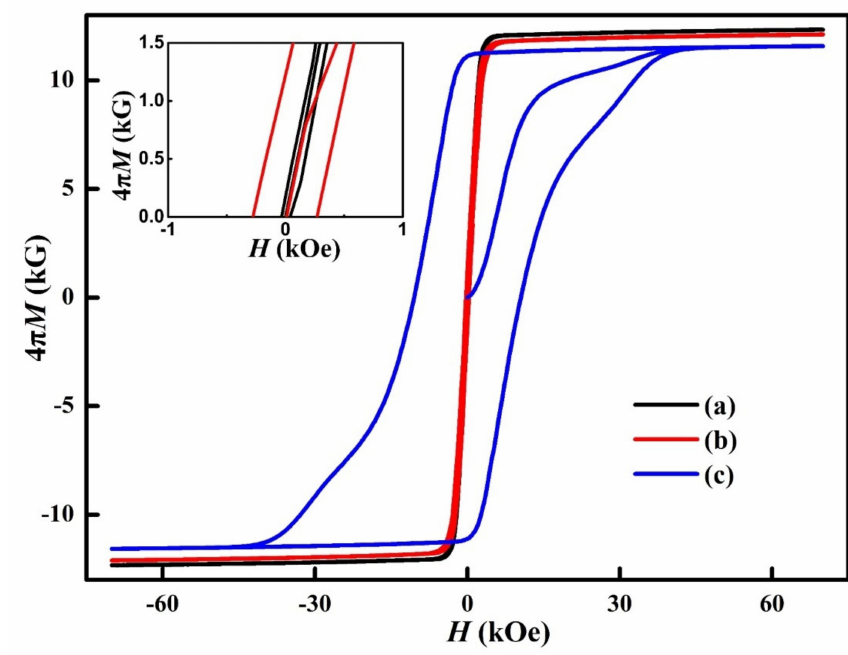
Figure 1. Initial magnetization curves and magnetization hysteresis loops of the samples at different states: solution-treated ( a ), aged for 0.5 h at 810 ◦ C ( b ), and the final magnet ( c ). The inset is an enlarged view of the curves for the solution-treated sample and the 0.5 h-aged